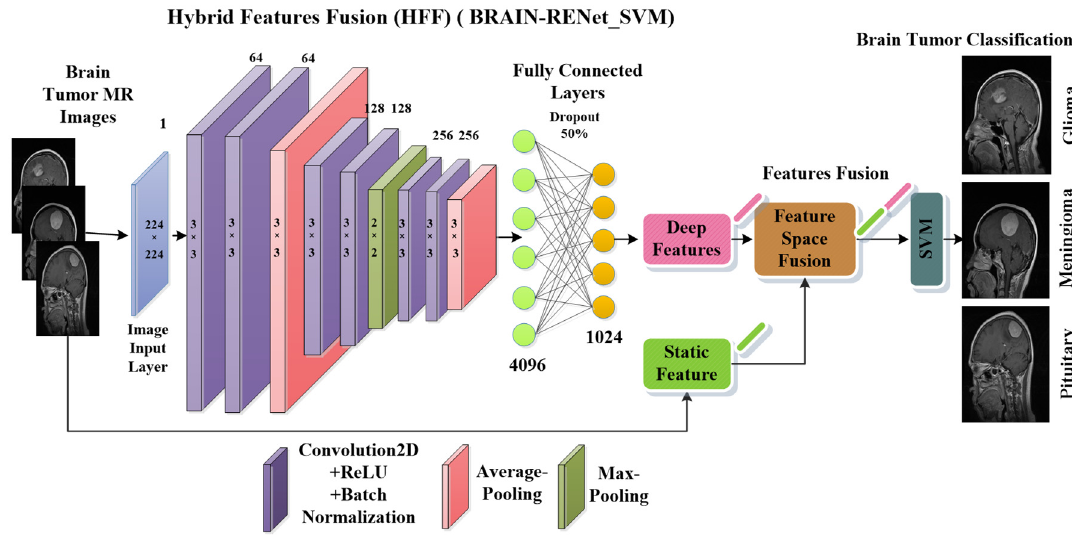
Figure 4. The proposed BRAIN-RENet deep CNN for brain tumor classification. The proposed BRAIN-RENet contains six convolutional blocks. Every block is comprised of one convolutional layer, ReLU, and batch-normalization. The convolution layer extracts the tumor-specific features while ReLU act as an activation function. At the end of each block, average- and max- pooling operation is applied to learn region uniformity and boundary features of brain tumors as illustrated in Equations (4) and (5). Region and boundary-based operators are implemented systematically to capture patterns of different types of brain tumors. The detailed architecture of the proposed BRAIN-RENet is illustrated in Figure 4. W (cid:2923),(cid:2924) (cid:3404) (cid:3533) (cid:3533) W (cid:2923)(cid:2878)(cid:2934)(cid:2879)(cid:2869), (cid:2924)(cid:2878)(cid:2935)(cid:2879)(cid:2869) (cid:2929) (cid:2935)(cid:2880)(cid:2869) (cid:2928) (cid:2934)(cid:2880)(cid:2869)